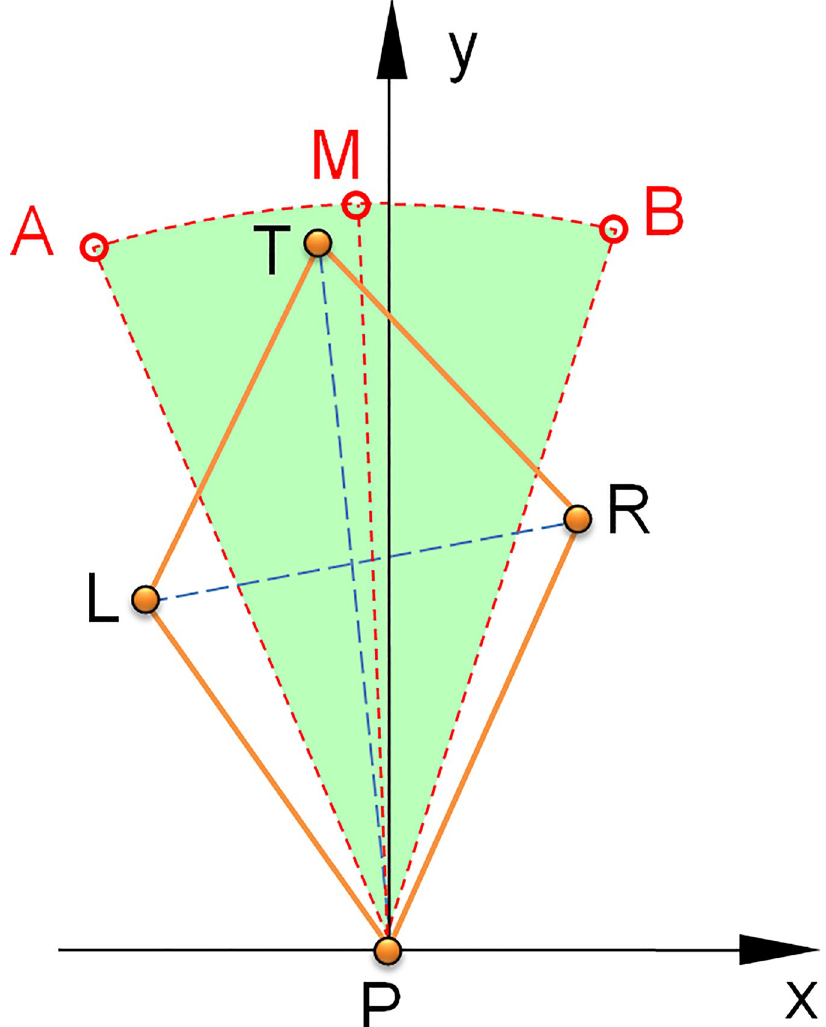
Fig 3. Calculation principle for the pick arrangement meshing